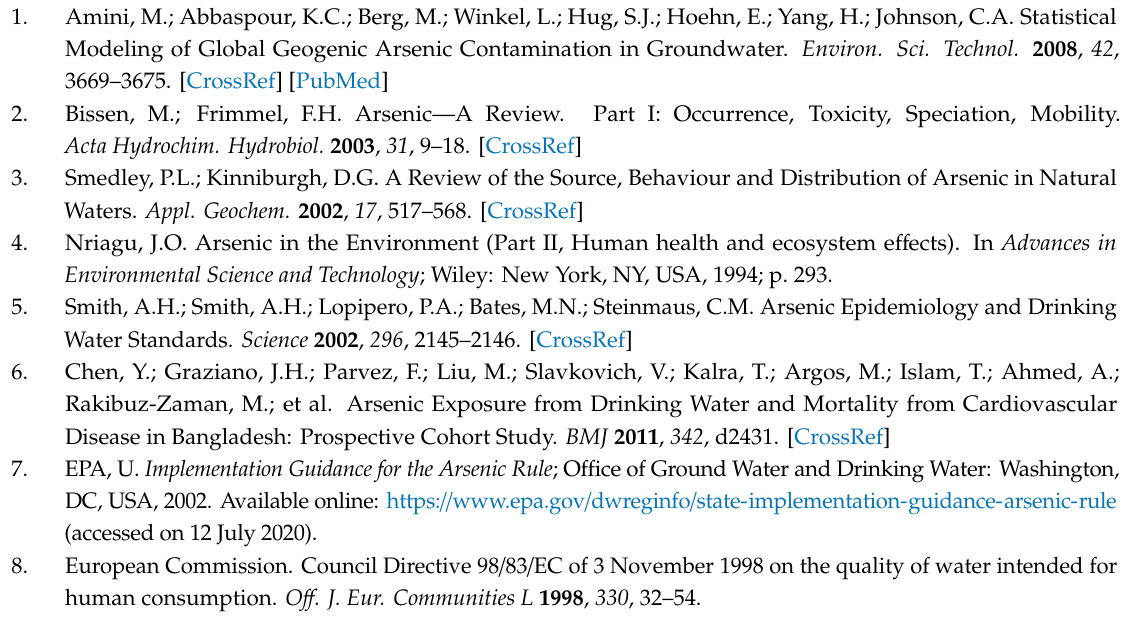
Figure S1. Schematic illustration for the synthesis procedure of citrate / FeCO 3 nanocomposites, Figure S2. Modelling data of (A) the distribution of citrate species without iron and carbonate ions as a function of pH, (B) the distribution of citrate species as a function of citrate concentration, (C) the distribution of Fe species, and (D) the saturation index (SI) of siderite at di ff erent citrate concentrations calculated by PHREEQC software with the minteq.v4 database, Figure S3. XRD patterns for the CF-NCs samples before and after arsenic (III and V)